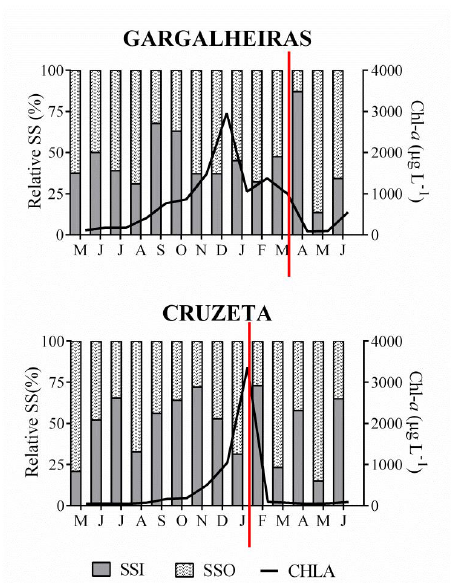
Figure 8. Concentrations of Inorganic Suspended Solids (ISS), Organic Suspended Solids (OSS), and Chlorophyll-a (Chl-a) in the Gargalheiras and Cruzeta reservoirs. The red line is indicating the highest rainfall in the period, which contributed to the increase in water depth, as can be seen in the